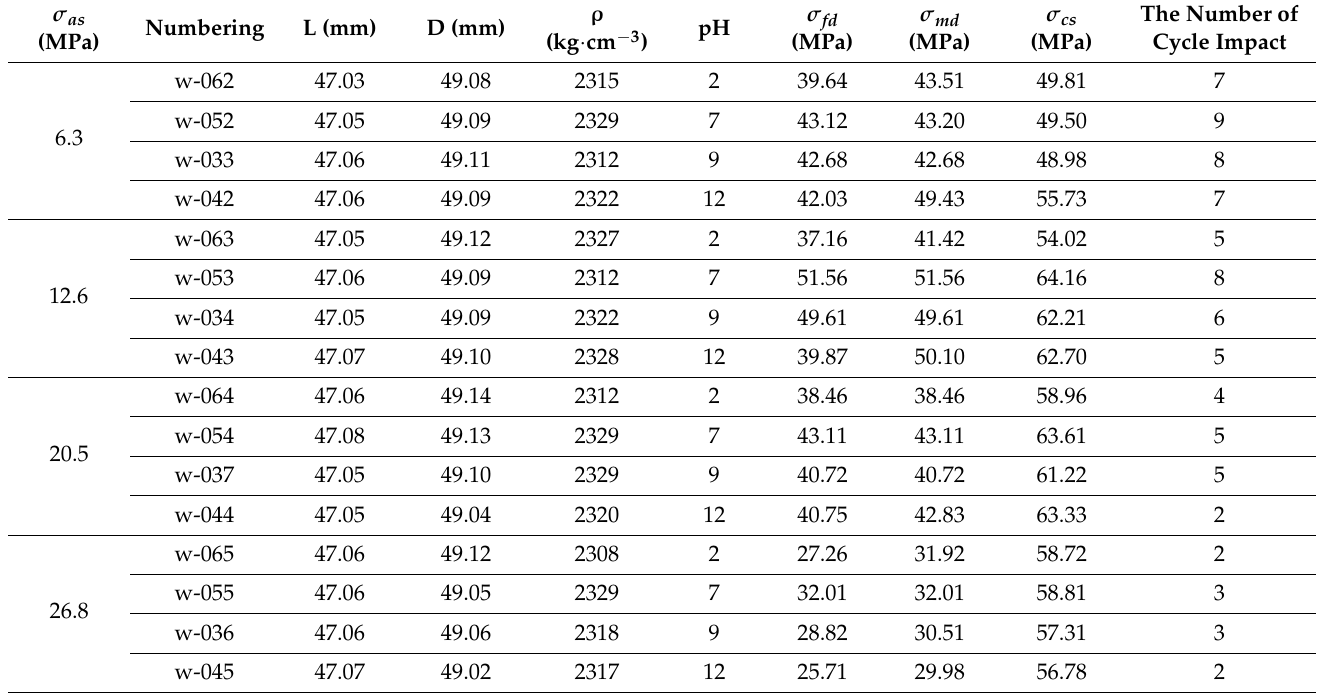
Table 3. Parameters of some specimens and the number of cyclic